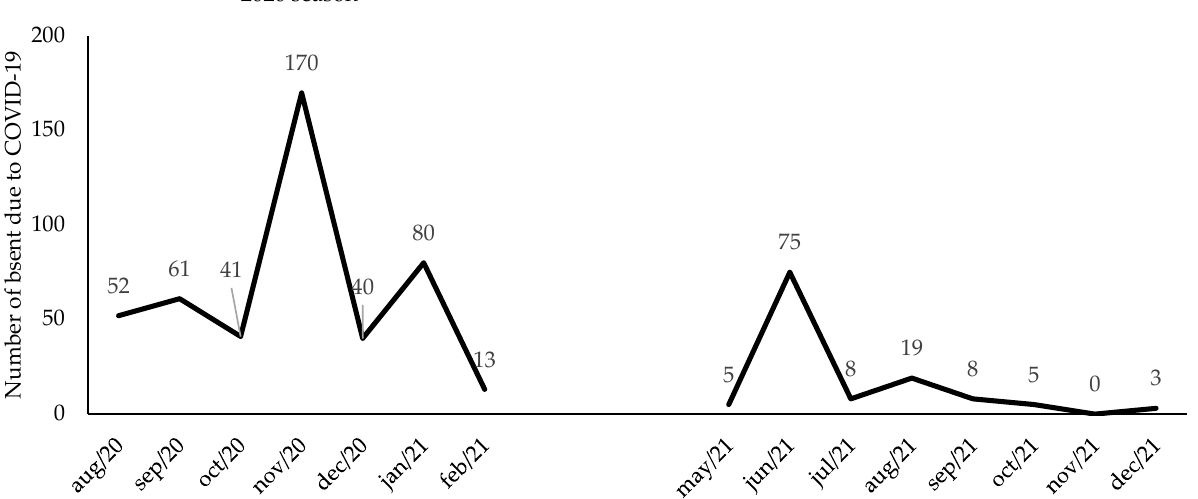
Figure 1. Soccer players absent because of the health protocol in the 2020 and 2021 seasons in the Brazilian Serie A championship. Table 2. Statistical and descriptive data across two seasons over the COVID-19 pandemic in the Brazilian Serie A championship.